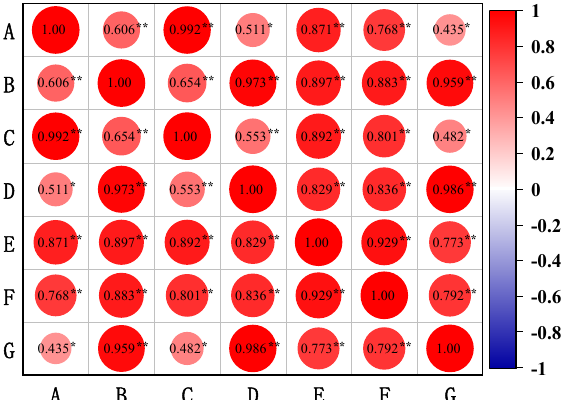
Figure 8. Correlation analysis of soil characteristics and soil adherence to minerals. The numbers in the circles represent the correlation coefficients between the parameters. ** and * indicate significant differences at p < 0.01 and p < 0.05, respectively. A, soil adhesion to minerals; B, soil pH; C, soil moisture content; D, soil exchangeable calcium ions; E, soil exchangeable magnesium ions; F, soil exchangeable sodium ions; G, soil exchangeable potassium ions.